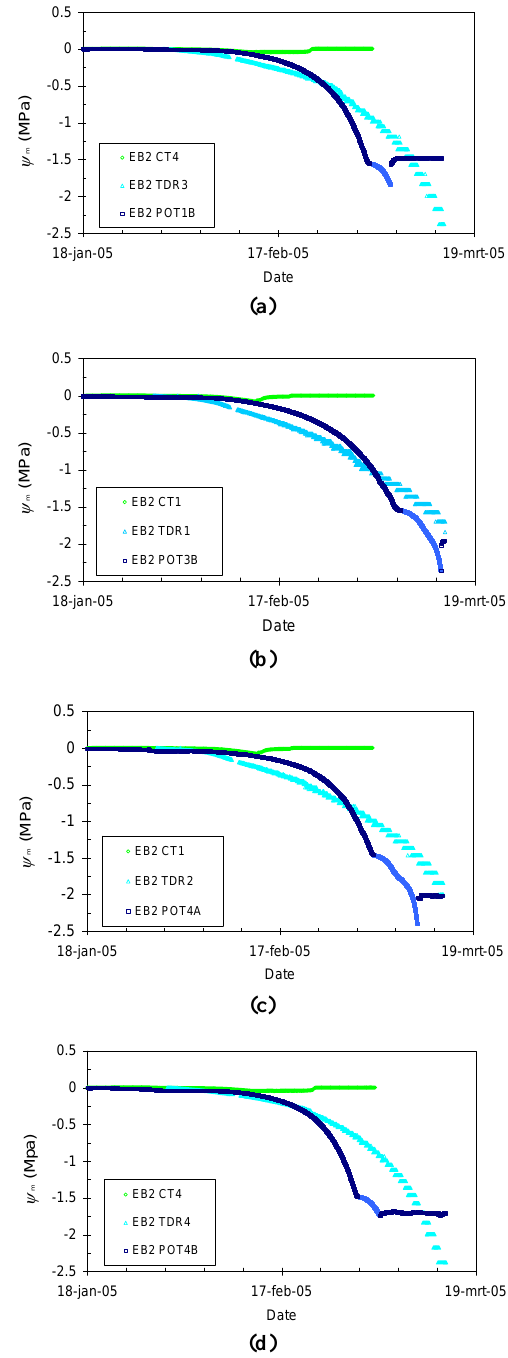
Fig. 7. Development of the matric potential ψ m in time measured by polymer tensiometers (POT), time domain reflectometry probes (TDR) and water-filled tensiometers (CT) in evaporation container 2 (EB2) that was filled with loam. Each sub-figure shows a POT- TDR pair installed opposite to one another, and the nearest